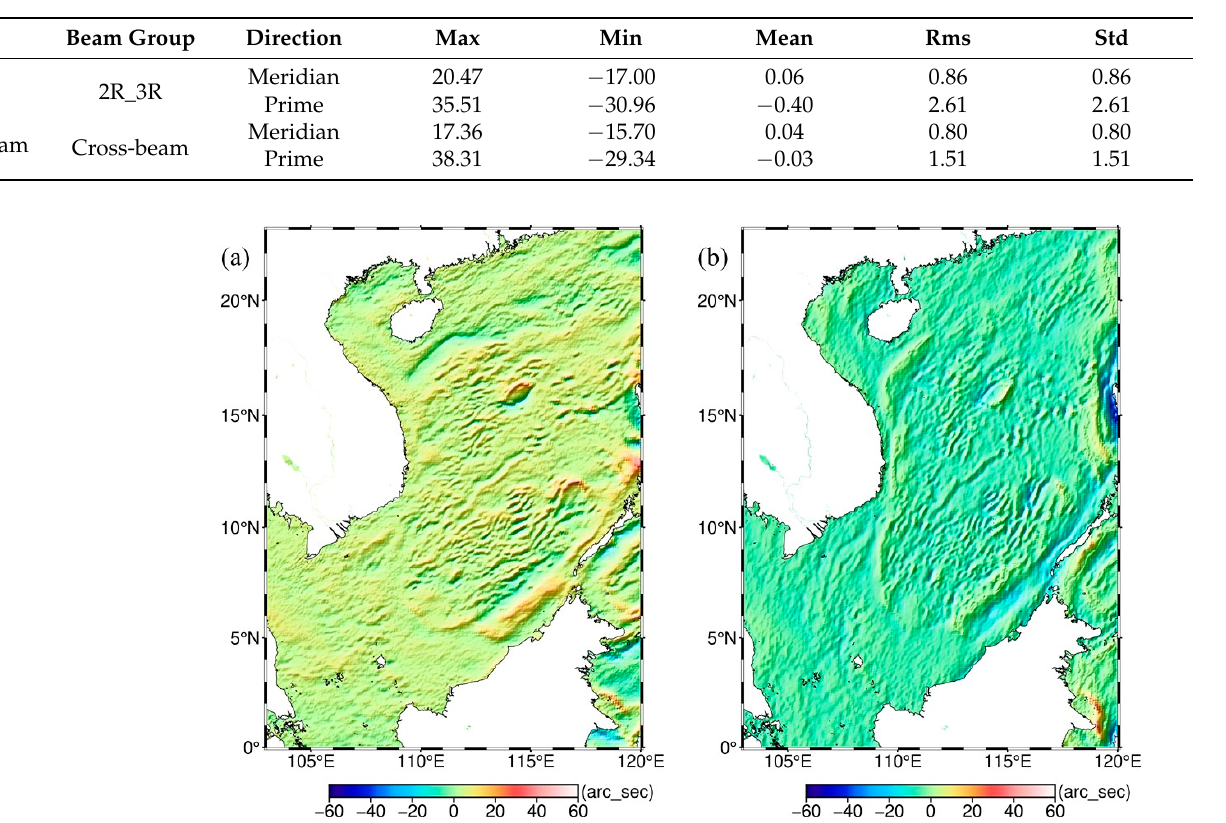
Figure 9. ( a ) The meridian component of the gridded DOV calculated by the joint along-beam DOV; ( b ) the prime vertical component of the gridded DOV calculated by the joint along-beam DOV. Table 16. Statistics of differences between gridded DOVs calculated by the joint along-cross beam